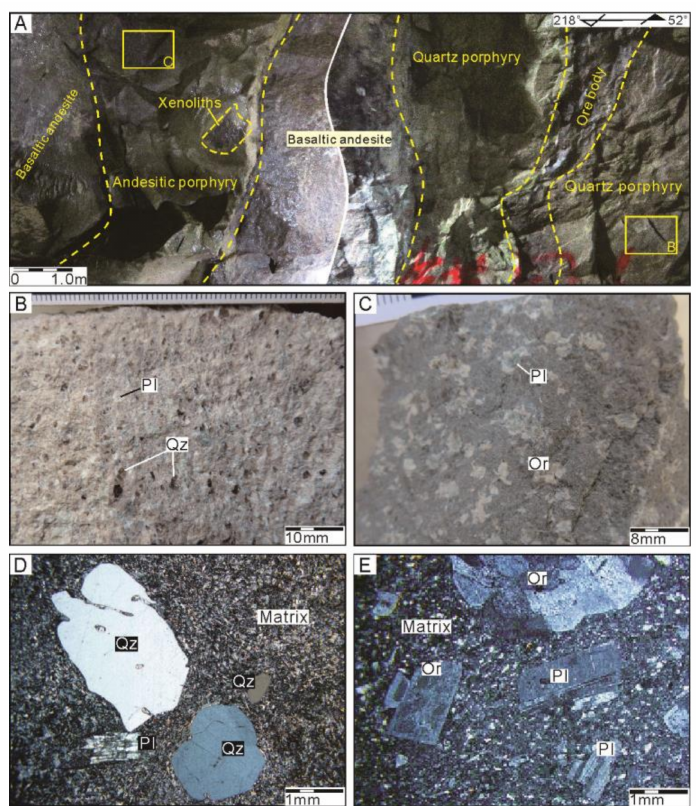
Figure 3. ( A ) Quartz porphyry cut by an ore vein and quartz porphyry cut by andesite porphyry; ( B ) hand specimen of quartz porphyry; ( C ) gray white quartz porphyry exposed in the field; ( D ) quartz porphyry showing mainly quartz phenocrysts and very few orthoclase and plagioclase phenocrysts; ( E ) andesite porphyry showing mainly plagioclase phenocrysts and very few orthoclase phenocrysts. Or–orthoclase; Pl– plagioclase;